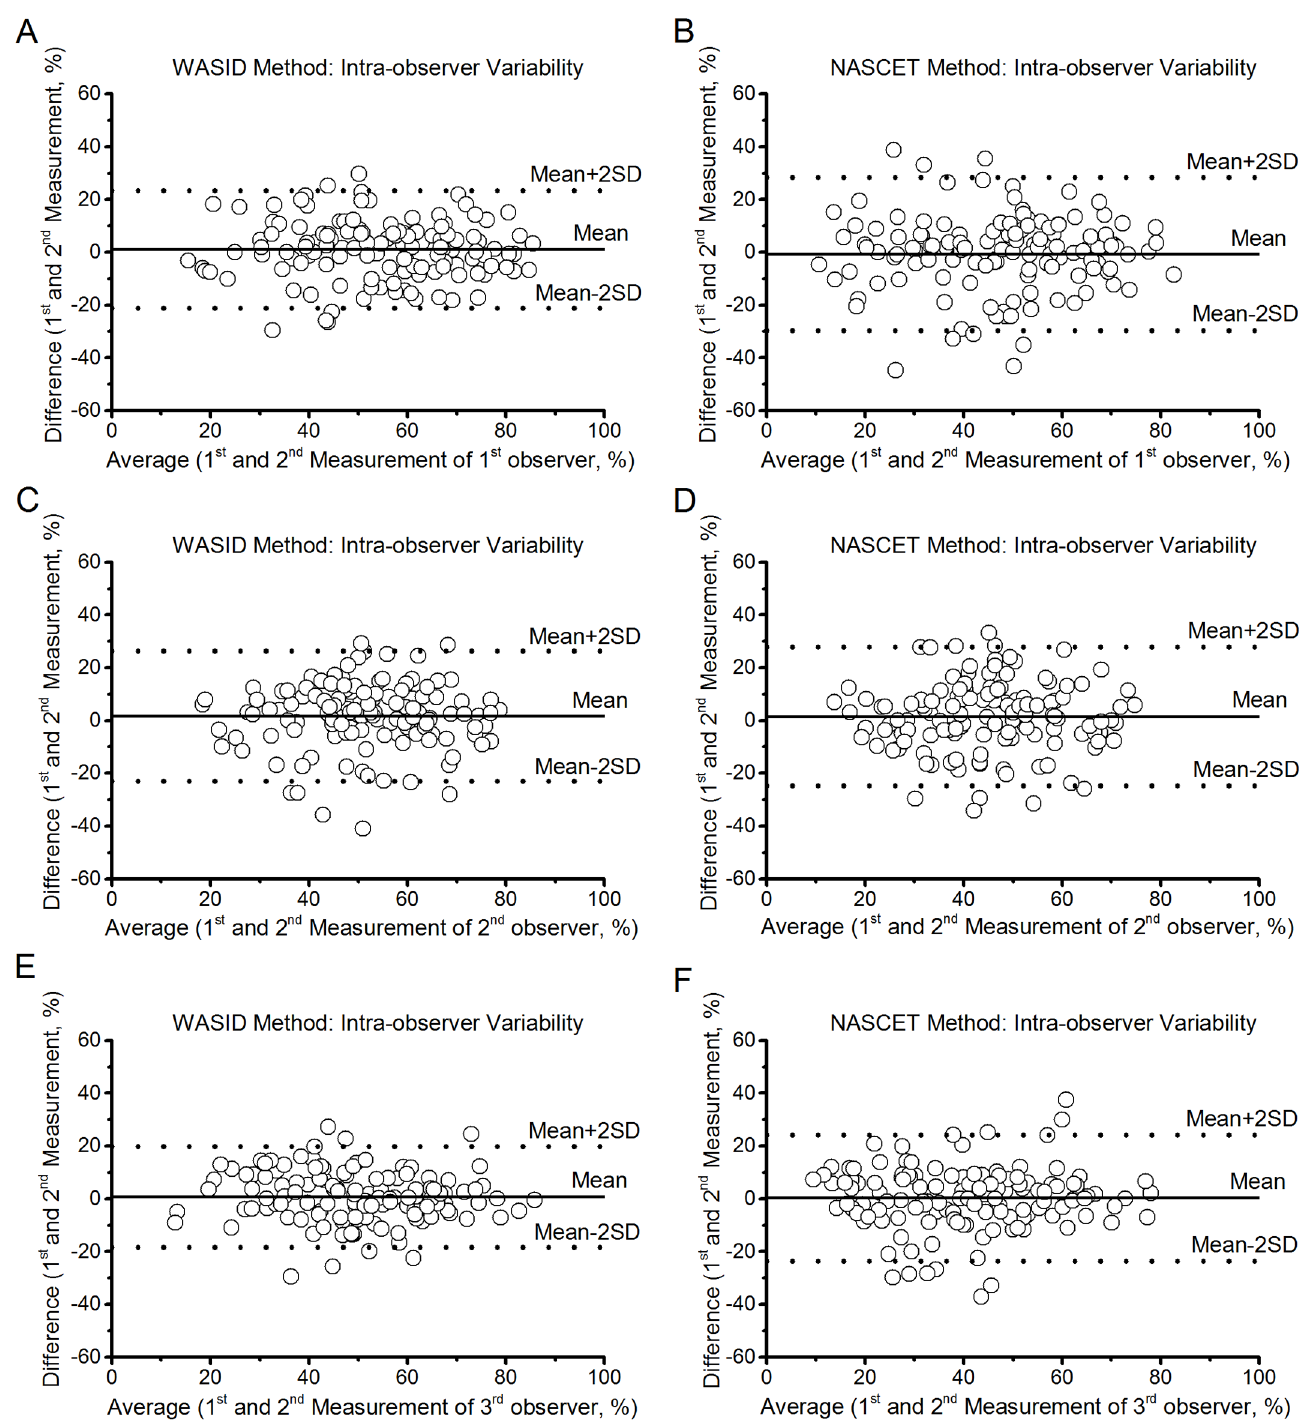
Fig 3. Bland-Altman plots of intra-observer reproducibility of the NASCET and WASID methods. (A, C and E) WASID method for Observer 1, 2 and 3, respectively. (B, D and F) NASCET method for Observer 1, 2 and 3, respectively.